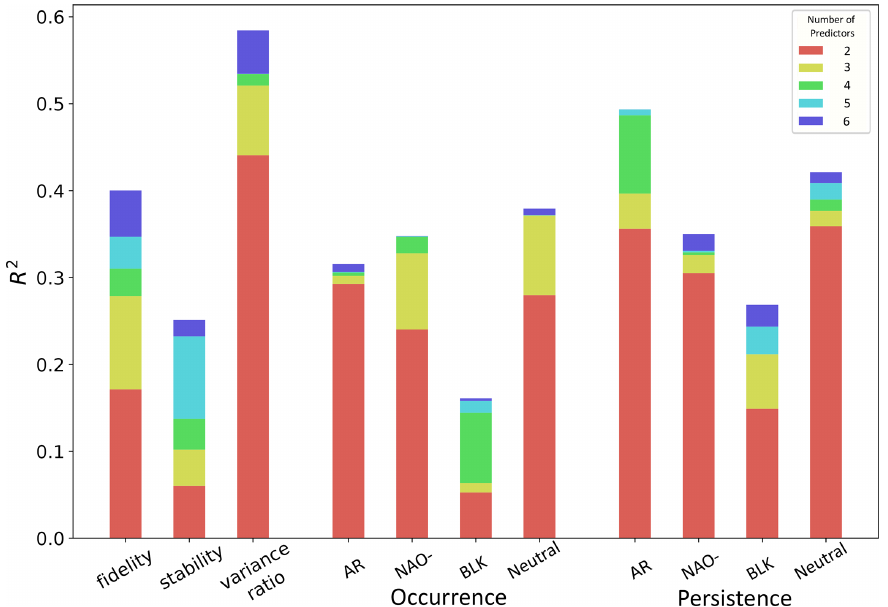
Figure 13. The fraction of inter-model variance in regime metrics explained by the multi-linear ridge regression model as a function of the number of predictors included.